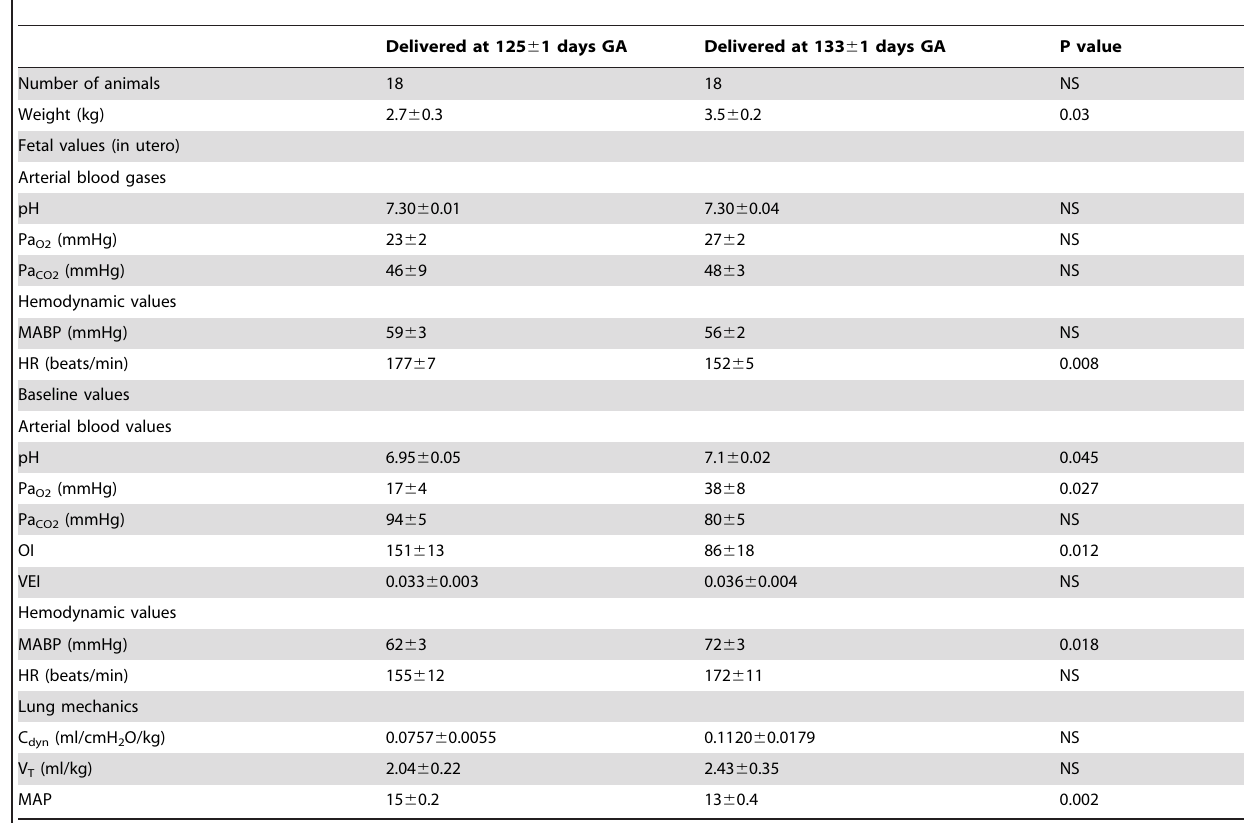
Table 1. Characteristics of preterm lambs during fetal life and before pulmonary treatment at the two gestational ages